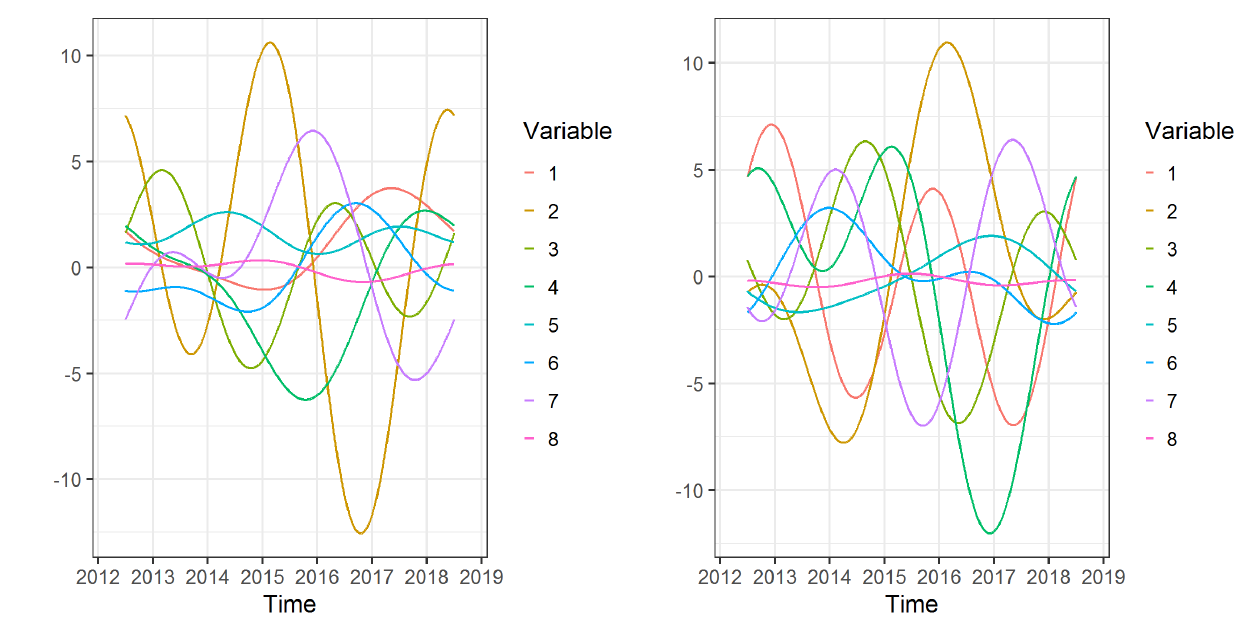
Figure 4. Weight functions for the first (left) and the second (right) functional discriminant coordinate. Table 5. Values of coefficients of the vector weight